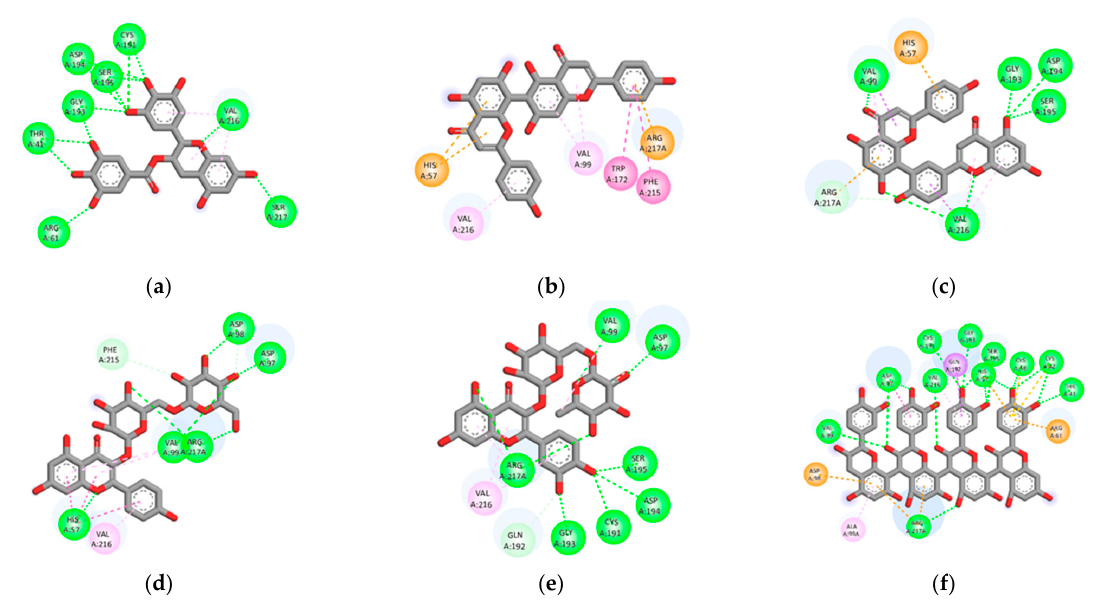
Figure 3. Molecular docking analysis of elastase (3HGP) is represented by the 2D diagrams of interaction between 3HGP and positive control and compounds with the lowest binding energy: ( a ) epigallocatechin gallate (positive control); ( b ) agathisflavone; ( c ) amentoflavone; ( d ) kaempferol 3-O-gentiobioside; ( e ) rutin; ( f ) tetramer of proanthocyanidin.